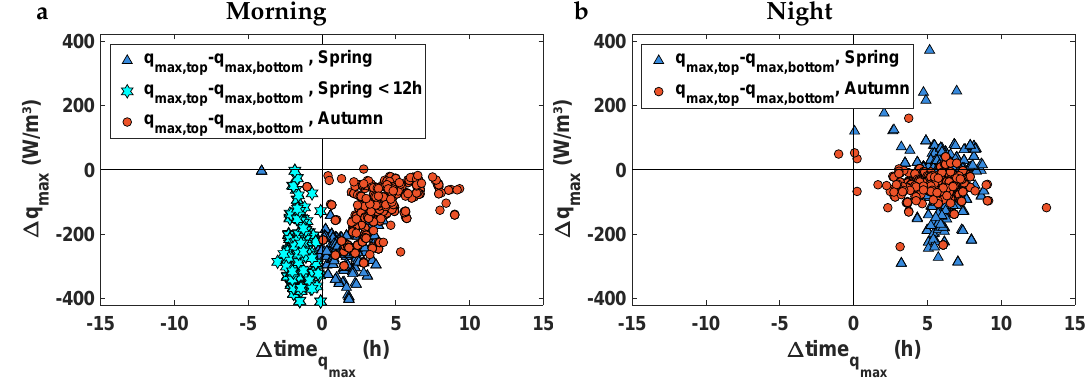
Figure 5. Here we plot the difference between q max at the top part of the lift and at the bottom part, ∆ q max , against the difference between t q max at the top part of the lift and at the bottom part, We plot in panel ( a ) the results of the lifts set in the morning, and in panel ( b ) those set at